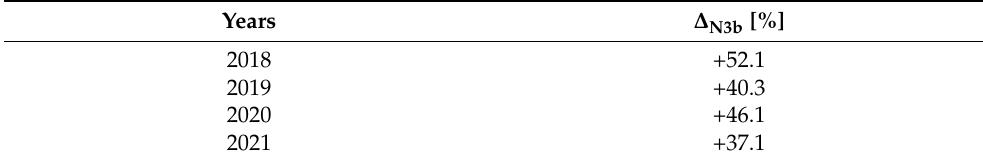
Table 15. N3b criteria percentage variation: MV events.